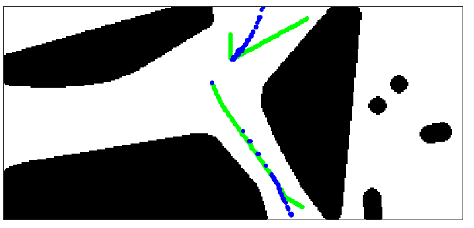
Figure 18. The result of skeleton shape optimization.